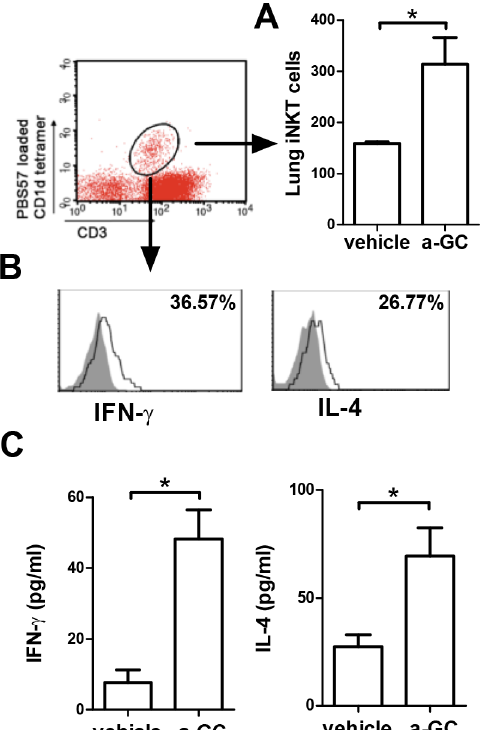
Fig 1. Intranasal α -GalCer administration activates lung iNKT cells to secrete cytokines. Mice were intranasally administered with vehicle or α -GalCer. Two hours later, BALF was collected. (A) The absolute numbers of iNKT (CD3 + PBS57 loaded CD1d tetramer + ) cells were measured. (B) IFN- γ and IL-4 expression from iNKT cells was assayed by intracellular staining with anti-mouse IFN- γ and IL-4 Abs. The shaded area is an isotype control; the open area reflects cytokine expression. The percentage of IFN- γ and IL-4-producing iNKT cells were shown. (C) IL-4 and IFN- γ levels in the BALF were measured by ELISA. a-GC, α -GalCer. n = 5 mice for each group. * , p < 0.05 using Mann-Whitney U